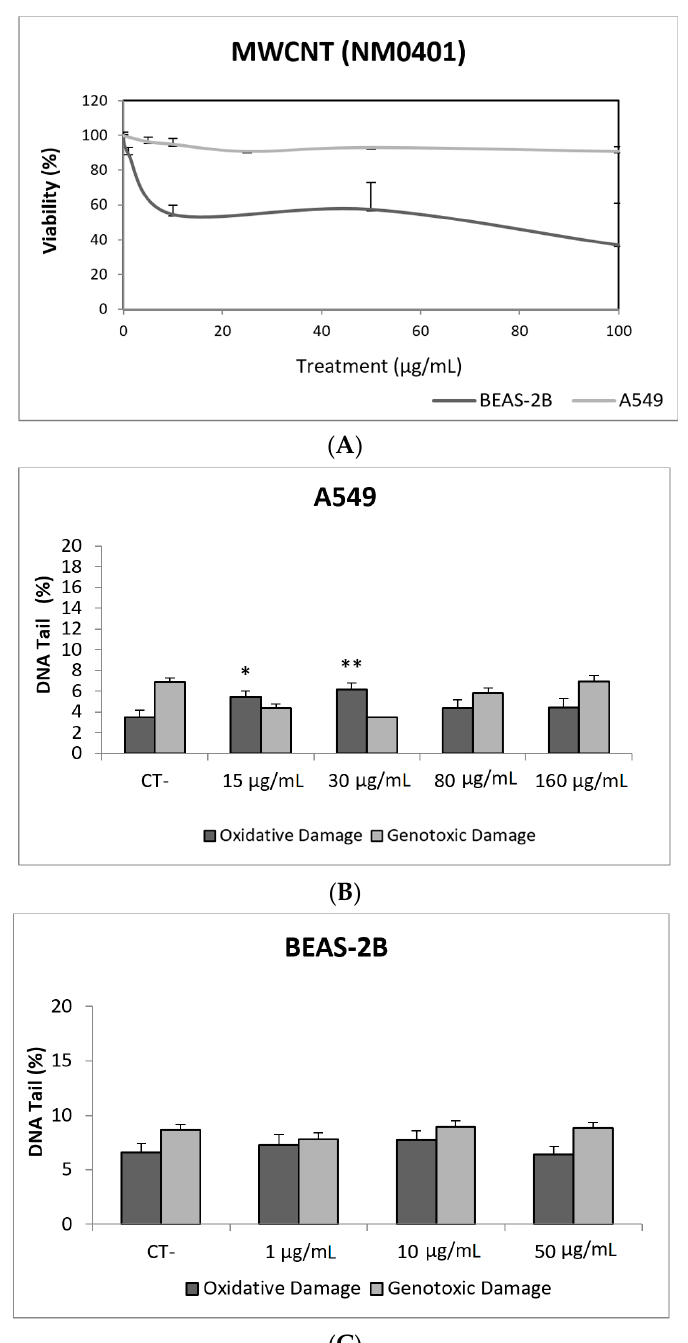
Figure 9. Results from the MWCNTs (NM401), on A549 and BEAS-2B cells. ( A ) Toxicity curves for both cell lines. ( B ) Genotoxicity results obtained in A549 cells. ( C ) Genotoxicity results obtained in BEAS-2B cells. Genotoxicity data are plotted as mean ± SEM of two independent experiments. * p ≤ 0.05, ** p ≤ 0.01 (one way-ANOVA). CT, control.